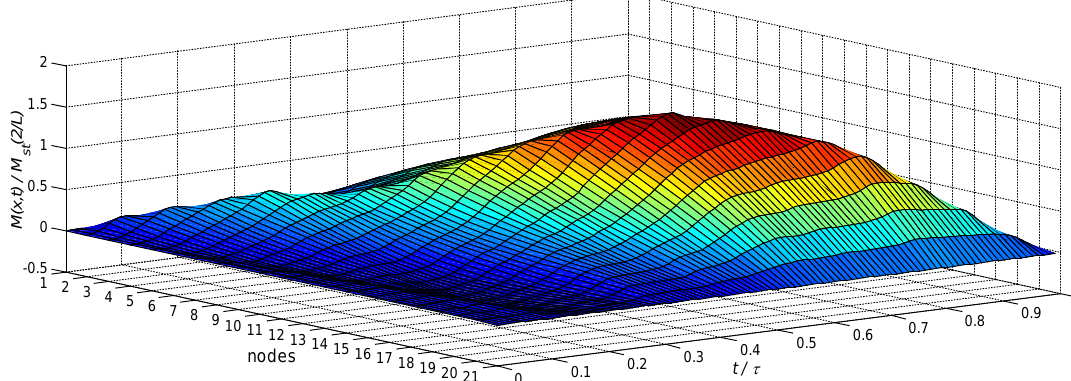
Figure 8. Moment–time graph at each beam node.